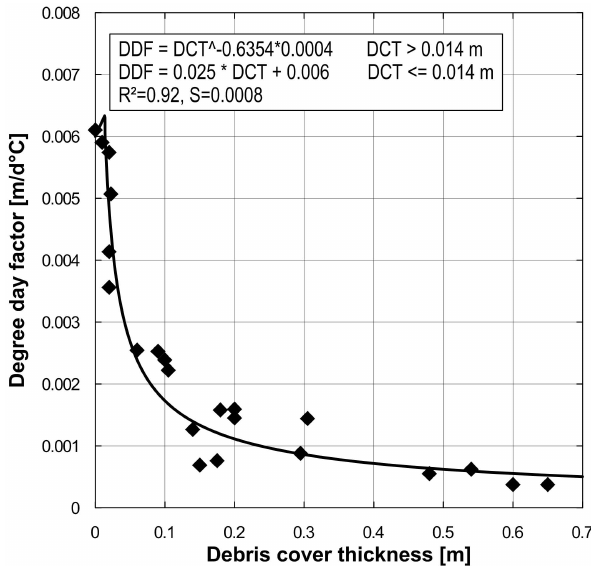
Fig. 2. Degree day factors of individual stakes plotted against debris cover thickness. The black line represents the empirical equations used in the ablation model. R 2 is the coefficient of determination and S is the standard error of the